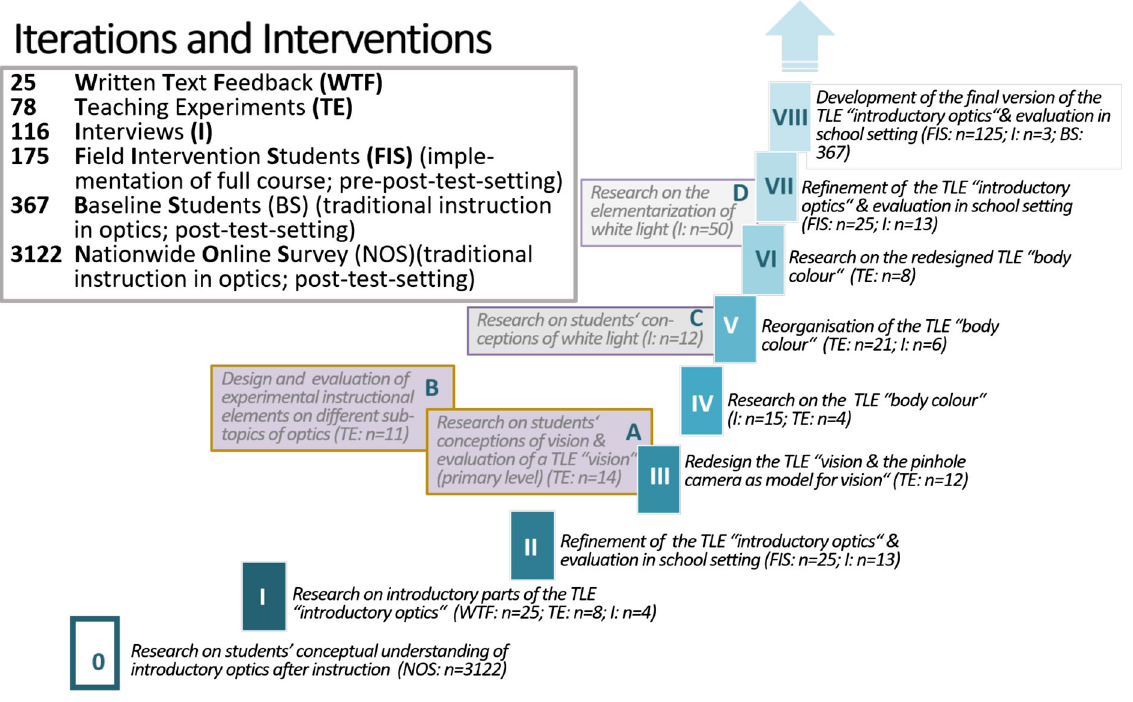
FIG. 4. Design cycles and interventions in the design process of the optics